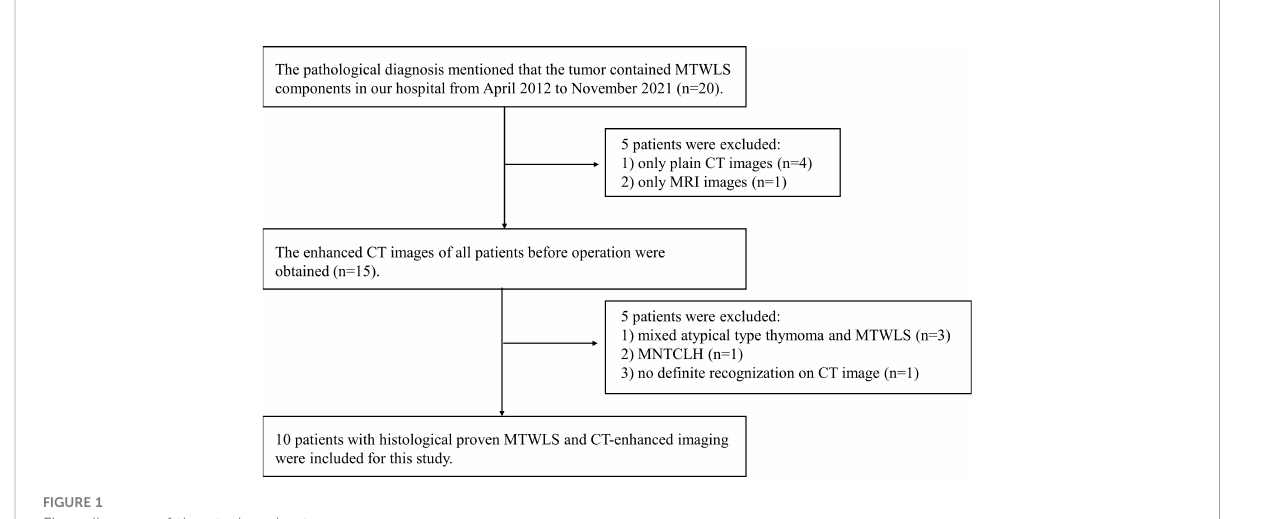
FIGURE 1 Flow diagram of the study